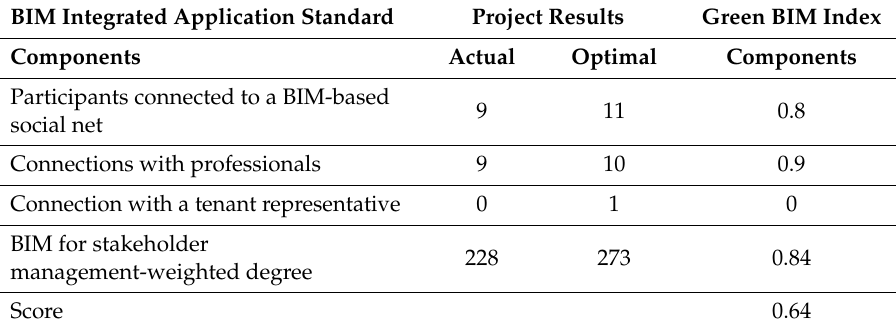
Table 3. Green BIM Index findings.